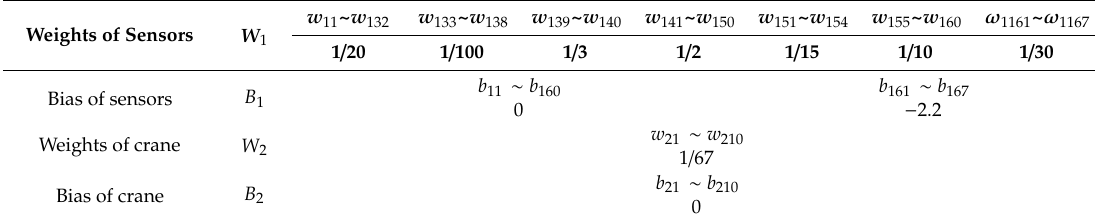
Table 2. Weights and bias of the CNN for CHMS.